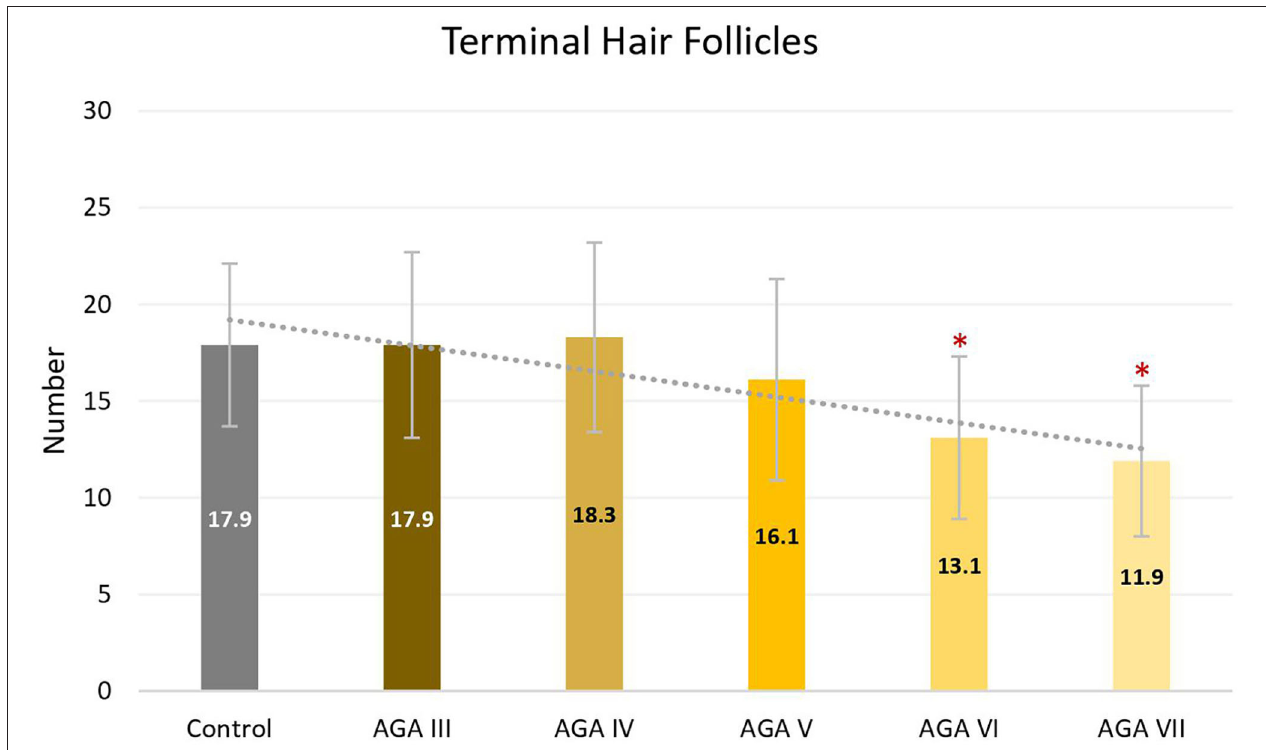
FIGURE 2 | Terminal hair follicles between controls and patient subgroups with different disease severity of androgenetic alopecia (AGA) . * P < 0.05 when compared to the control